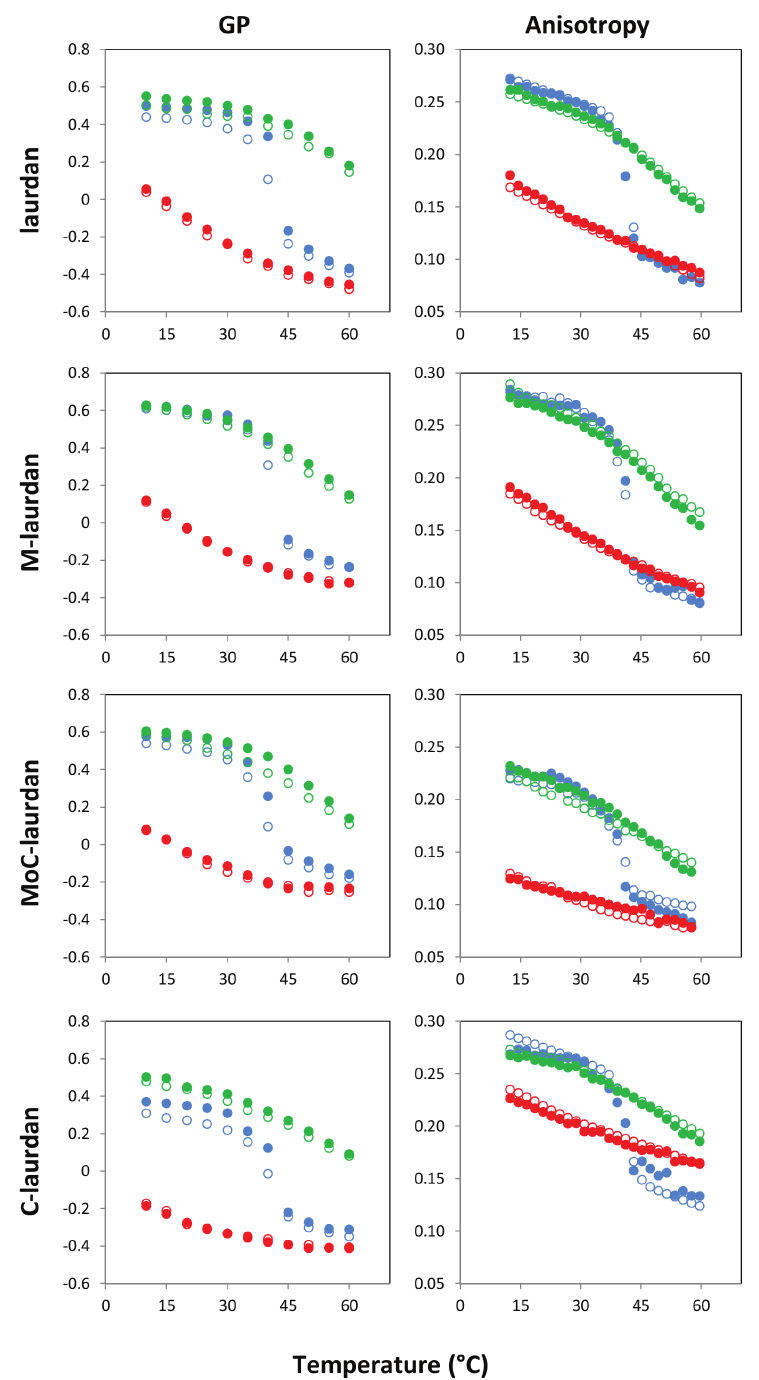
Supplemental Figure S4. Comparison of GP and anisotropy experiments on LUVS labeled either by direct mixing of lipids and dyes or by the DMSO loading method. LUVs made of DPPC, DPPC/chol (6:4) and POPC (100 µM, sample volume 3 ml) were either prepared in presence of each of the four dyes laurdan, M-laurdan, MoC-laurdan and C-laurdan, or unlabeled LUVs were loaded with the dyes dissolved in DMSO. The final dye concentrations were 1 µM and the DMSO/water ratio 1:1000. GP and anisotropy were recorded as a function of temperature. Symbols: blue for DPPC, green for DPPC/chol (6:4) and red for POPC, filled symbols for LUVs prepared in presence of dyes and open symbol for DMSO loading method. As can be seen from the graphs, the two procedures used to label liposomes with dyes gave extremely similar